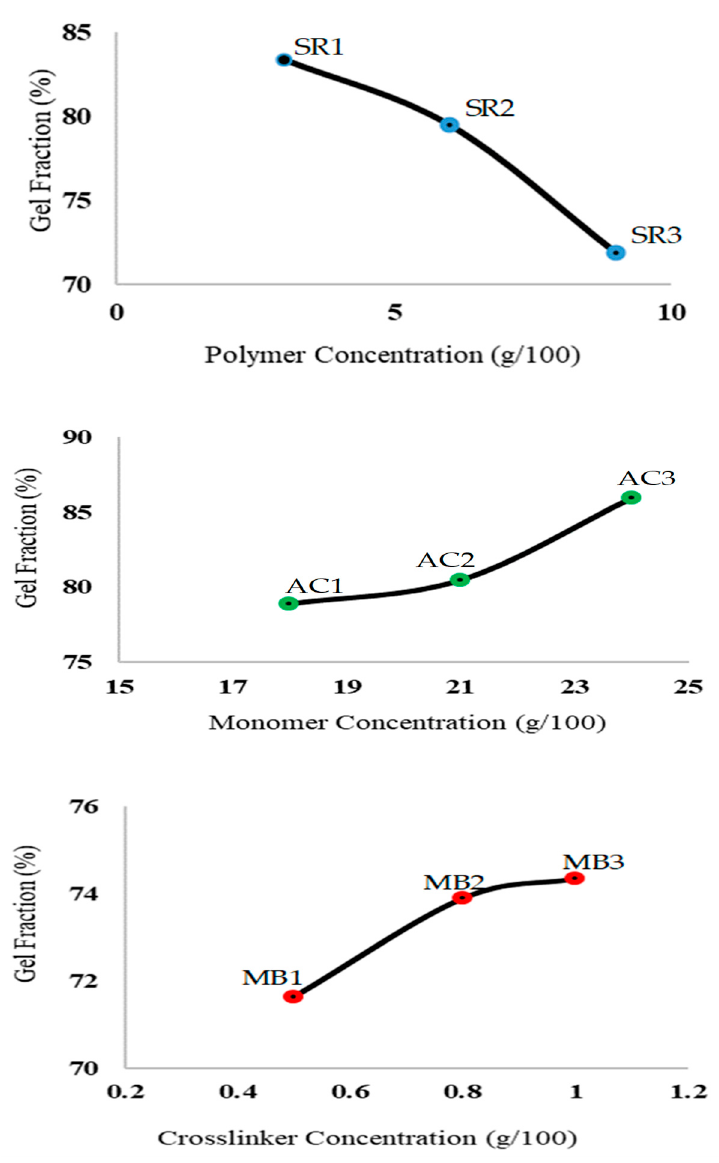
Figure 2. Sol-gel fraction findings of various formulations.